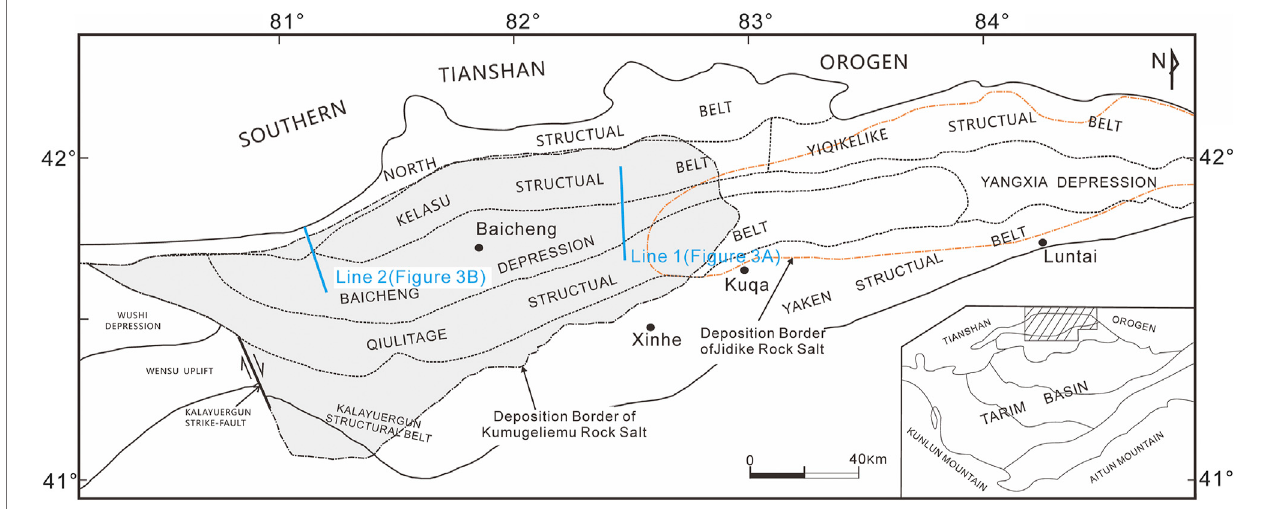
Frontiers in Earth Science |